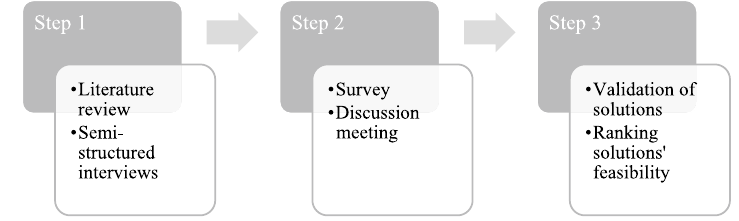
Fig. 1 Research approach. Source : own